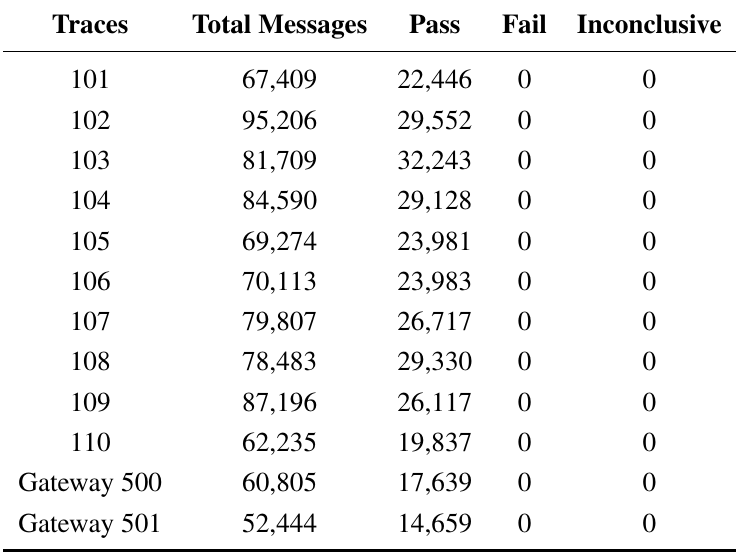
Table 6. Test results for Property 4 (Day 1).